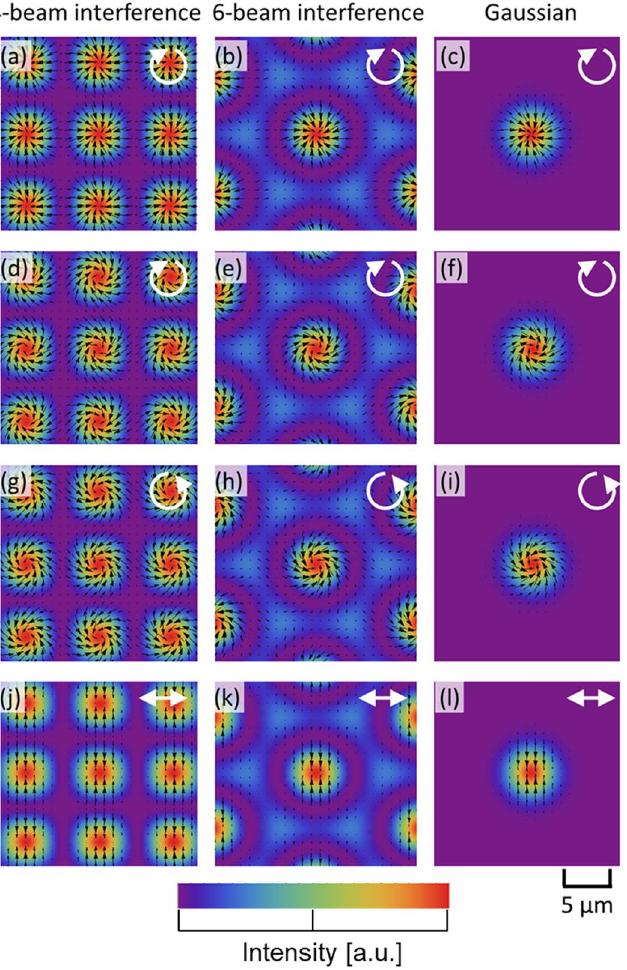
Figure 2. Optical radiation force distributions for a 4-beam, 6-beam, and Gaussian beam. The polarization is indicated on the images: ( a – f ) right-handed circular polarized, ( g – i ) left-handed circular polarized and ( j – l ) linearly polarized. In the simulation, 5 χ i (instead of χ i ) is applied in ( d – i ) to enhance the visibility of the azimuthal